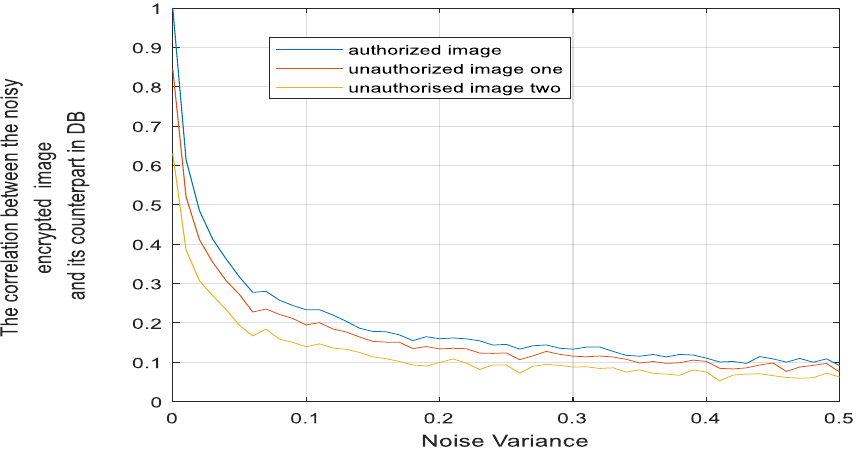
Figure 27. Effect of noise on the proposed system.